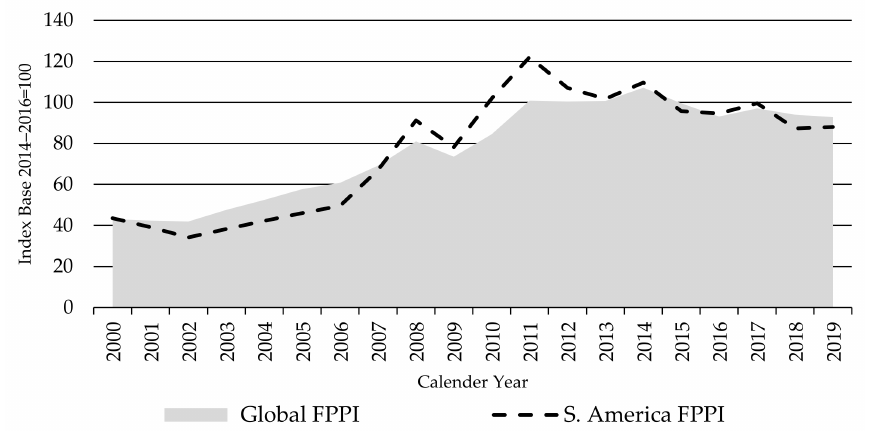
Figure 3. The Global and South America Finished Cattle Producer Price Indices FPPIs, source: own illustration.